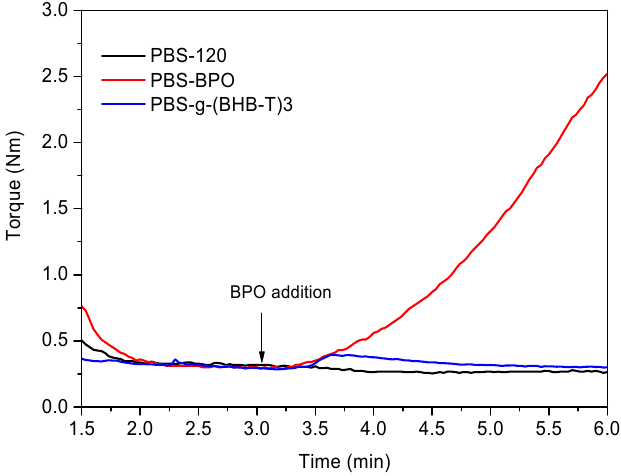
Figure 1. Torque curves of PBS-120, PBS-BPO, and PBS-g-(BHB-T)3.